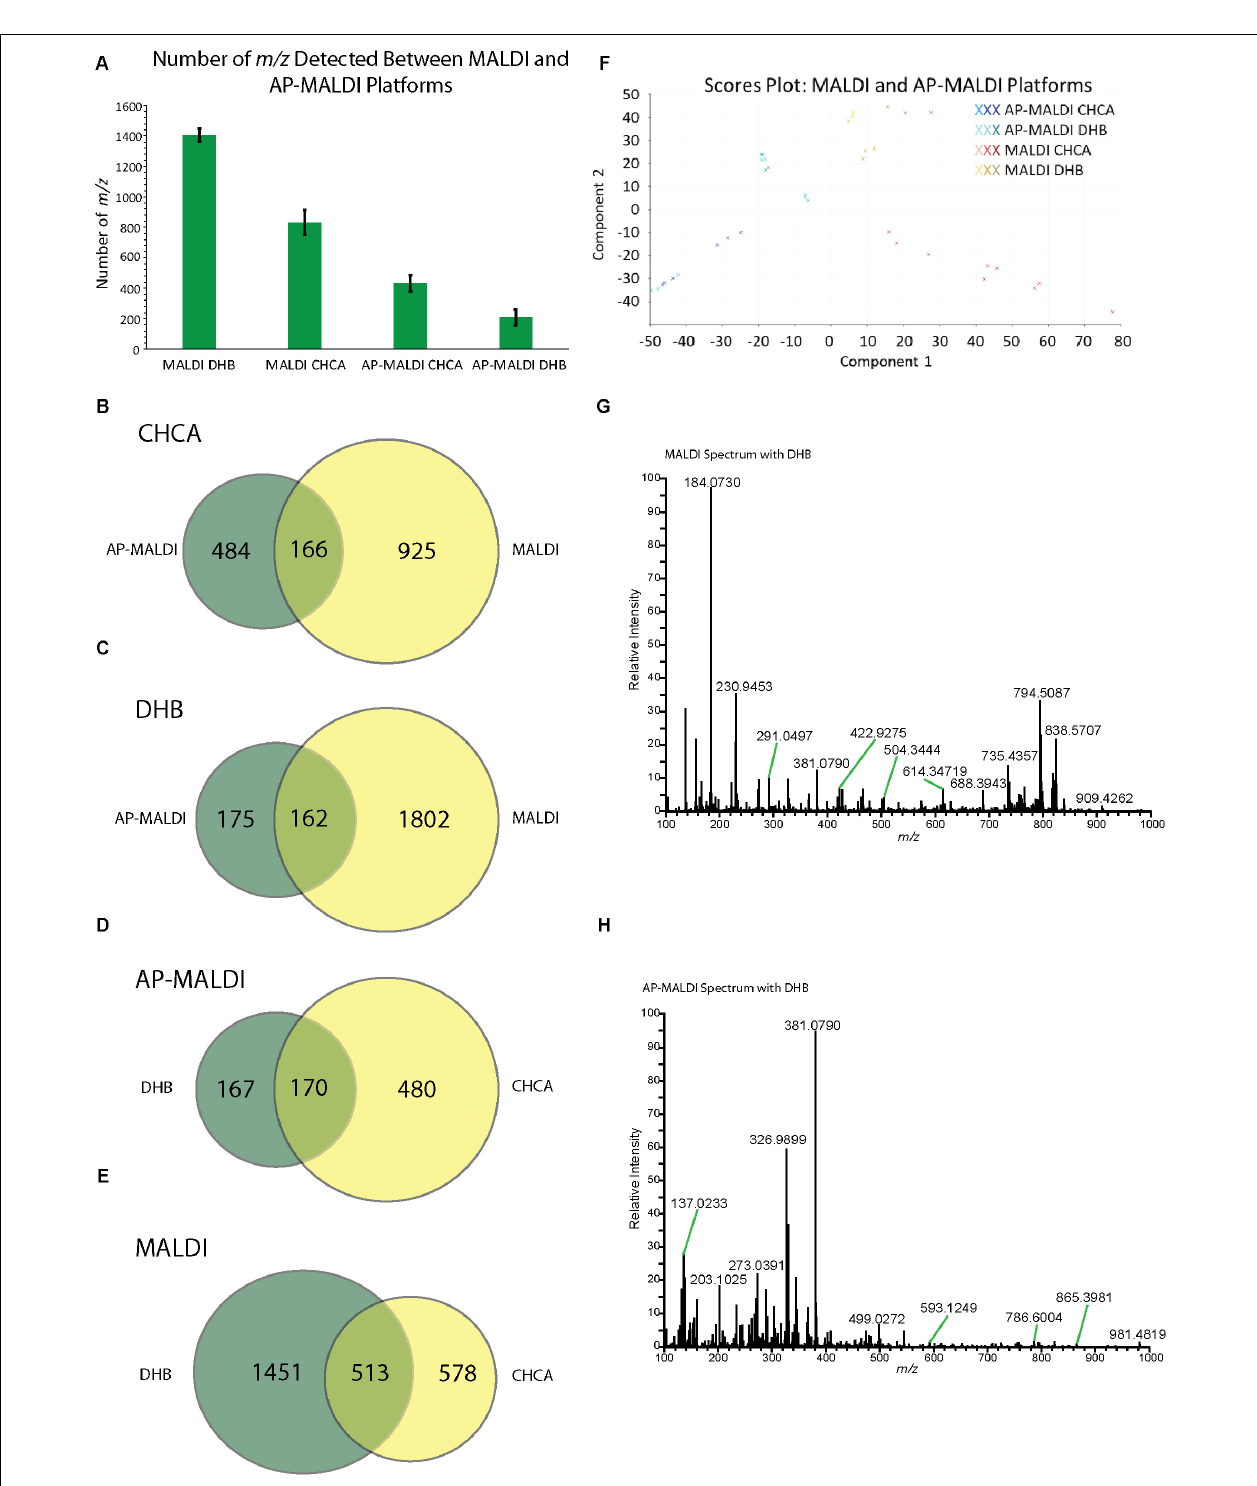
FIGURE 2 | Comparison of the vacuum MALDI and AP-MALDI QE-HF systems for imaging of control nodules. In (A) , the number of m/z detected for both systems with CHCA and DHB as matrices are shown. Error bars show the standard error of the mean. (B,C) Show Venn diagrams for the overlap in detected m/z values between the two systems for CHCA (B) and DHB (C) . Venn diagrams comparing the overlap between m/z observed with DHB and CHCA matrices are shown for the AP-MALDI (D) and MALDI (E) . The PCA plot for all the biological and technical replicates of control nodules imaged with either the AP-MALDI or MALDI platform with either DHB or CHCA is shown in (F) . For each condition technical replicates are all the same color and biological replicates are differing shades of a color. Example spectra averaged over the nodule with the DHB matrix are shown for the MALDI (G) and AP-MALDI (H) platforms.